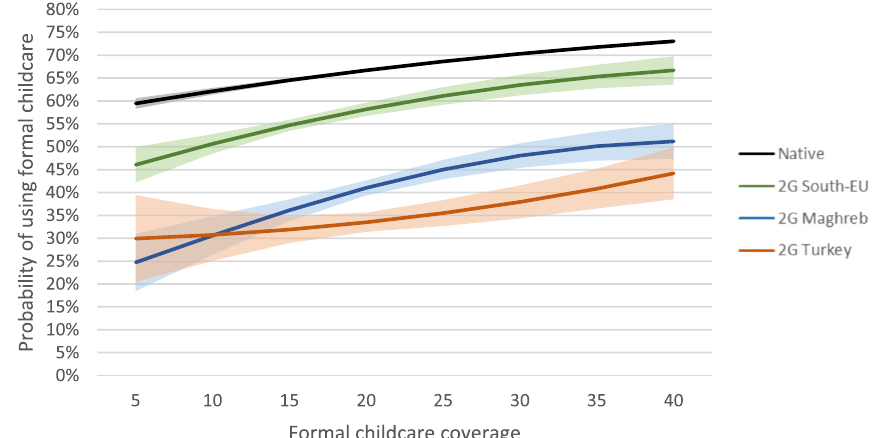
Fig. 7 Probability of using formal childcare at different levels of childcare coverage after controlling for socio-demographic characteristics (with 95% conf. interval), by mothers’ origin group. Predicted probabilities based on Model 4 including municipality fixed effects, coverage (quadratic specification), origin, origin * municipality, origin * coverage (quadratic specification), mothers’ educational level, mother’s age at first childbirth, the age of the first child at the end of the year, and the fathers’ migration background (Source: Belgian Census 2011 linked to longitudinal register data, longitudinal tax return data on childcare expenses and municipality-level data on childcare coverage from K&G and ONE. Calculations by authors)